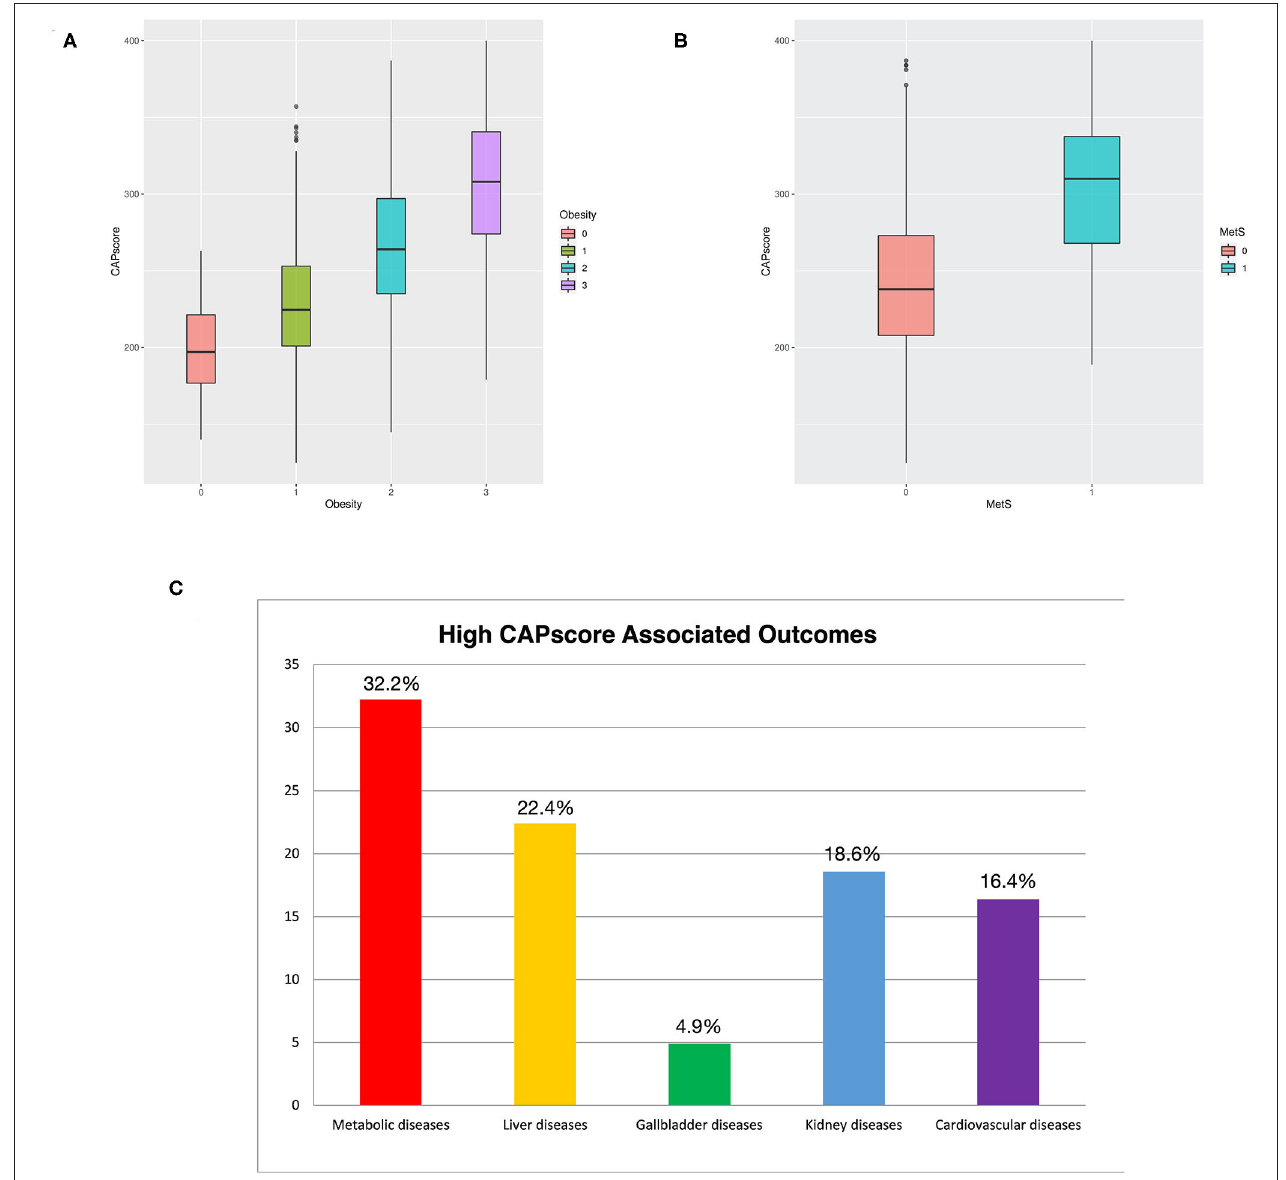
FIGURE 5 | (A) Boxplot of CAP score comparing patients with and without obesity. (B) Boxplot of CAP score comparing patients with and without MetS. (C) Percentage of outcome diseases among patients with CAP score of higher more than 260. Patients that were loss during follow-up were deleted in the calculation of